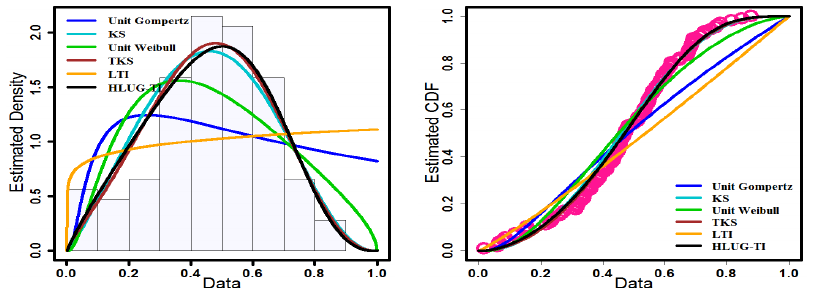
Figure 13. Estimated densities and empirical ( left ) and estimated cdf ( right ) for Data Set II.